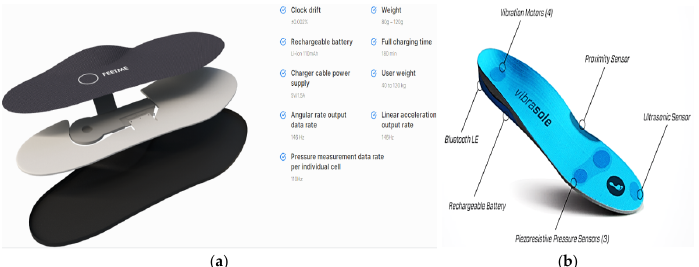
Figure 8. Top View of the FeetMe [43] ( a ) and Vibrasole insoles, Adapted from [44] ( b ).